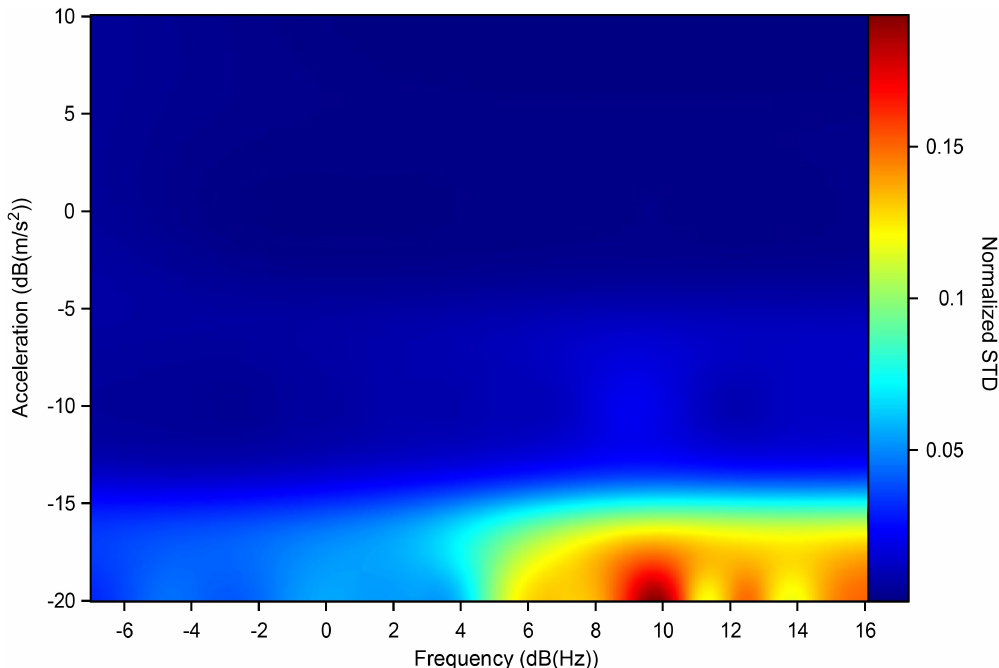
Figure 7. STD of the measurements as interpolation of the values obtained by shaking